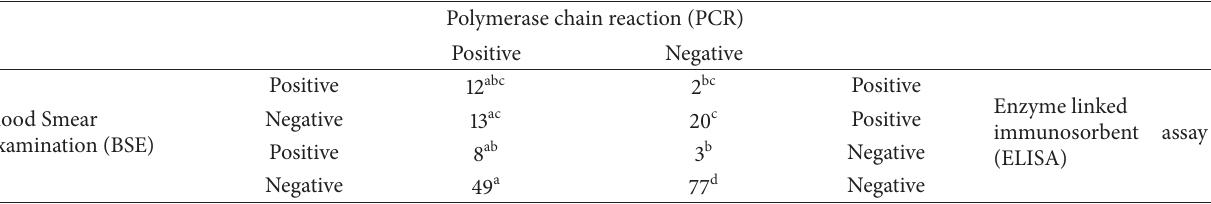
Table 2: Correlating between the findings of Blood Smear Examination (BSE), Enzyme Linked Immunosorbent Assay (ELISA), and Polymerase Chain Reaction (PCR).